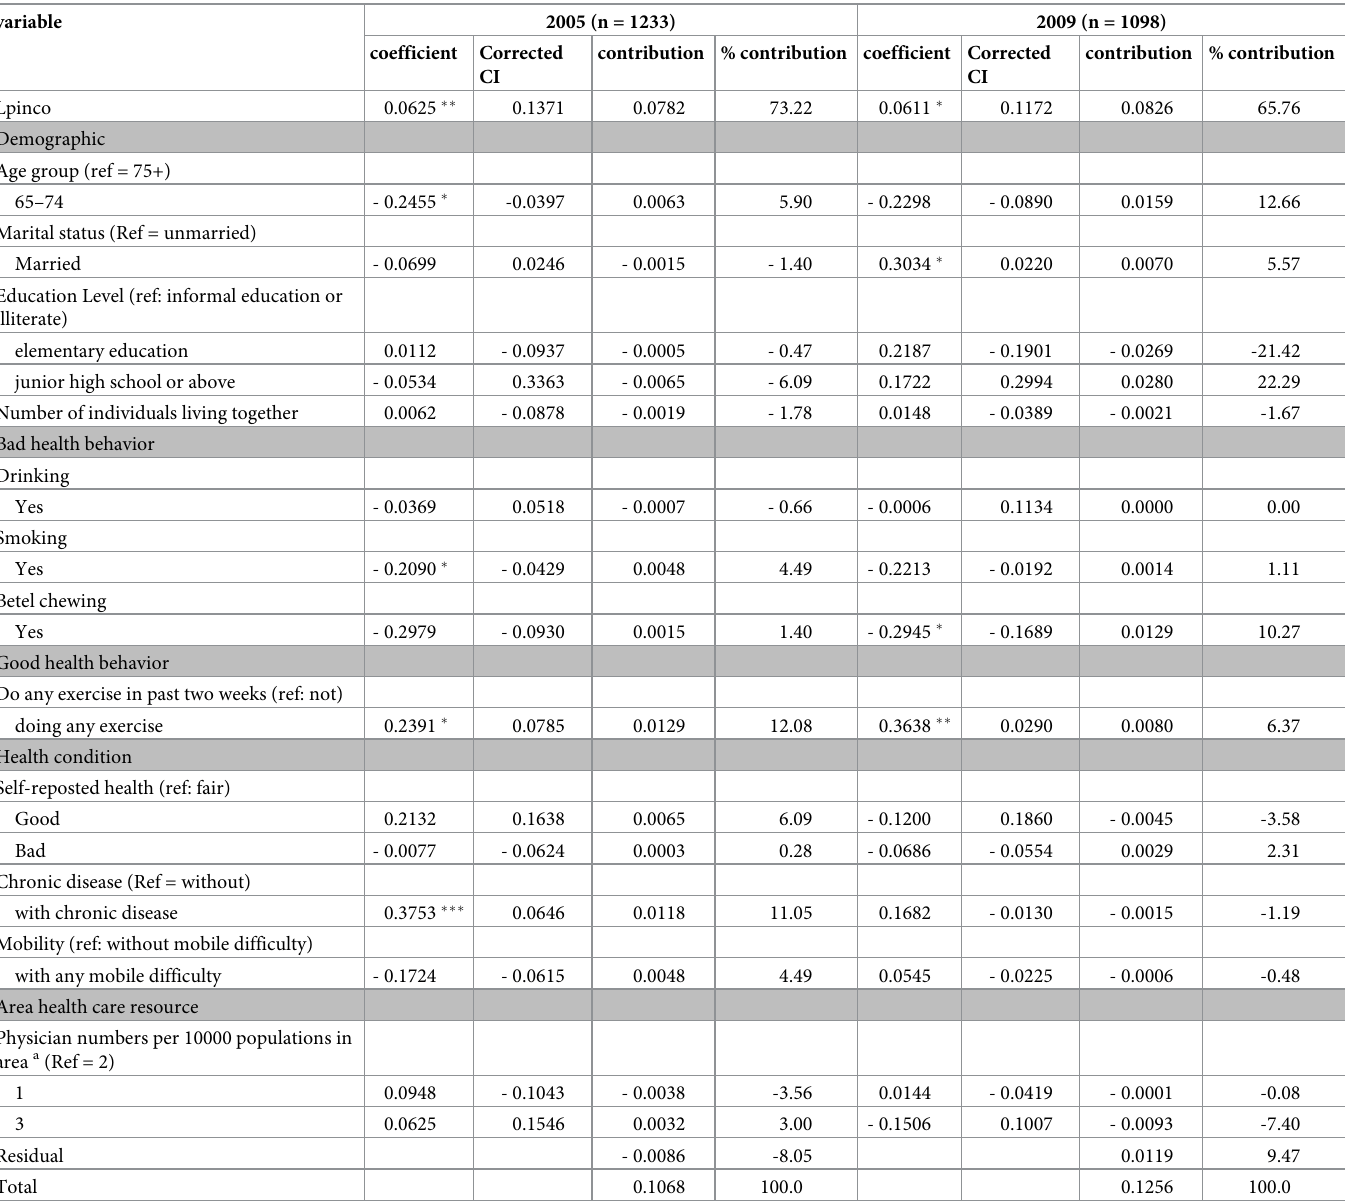
Table 4. Variable contributions to unequal use of health check-ups in 2005 and 2009 from probit regression,